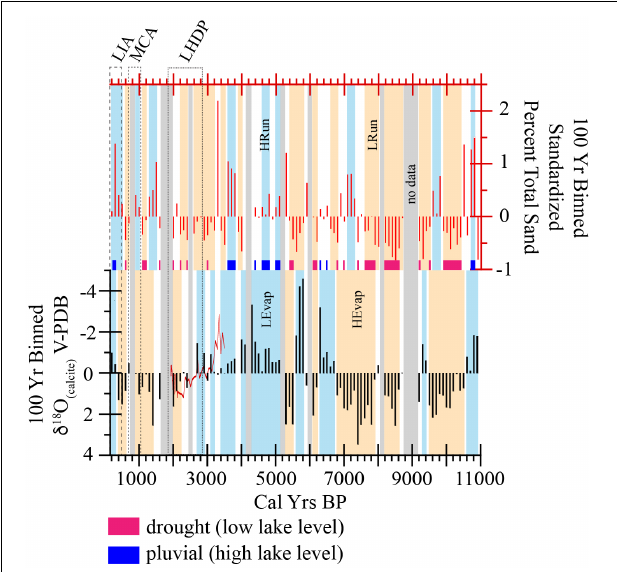
occur at Lake Elsinore. δ 18 O ( calcite ) show a weak, but positive correlation to both LOI 550 ◦ C ( r = 0.23, p < 0.0001, n = 491) and LOI 950 ◦ C ( r = 0.21, p < 0.0001, n = 491). δ 13 C ( calcite ) range from a minimum of − 9.1